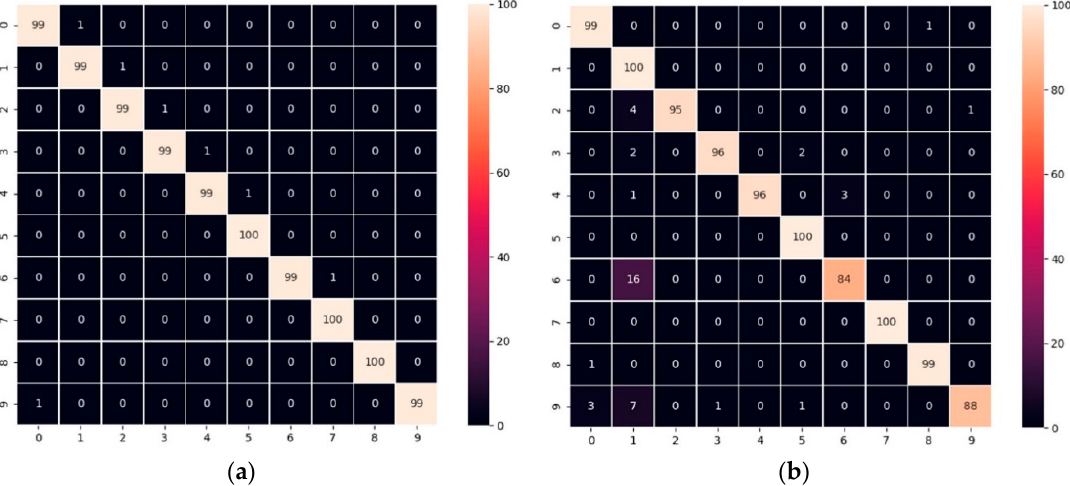
Figure A3. Confusion matrix for RTD dataset using: ( a ) LSTM and ( b ) CNN networks. The false recognition rate for CNN is higher than for LSTM.